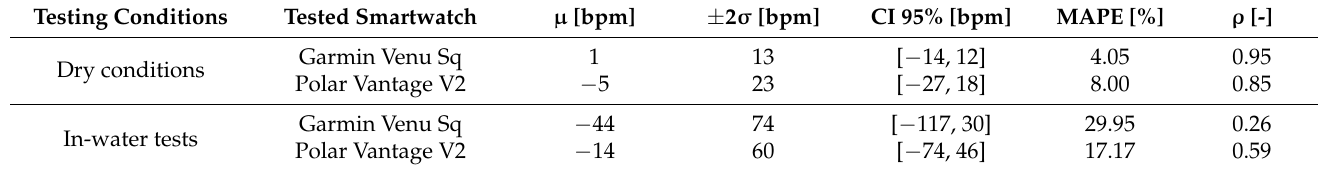
Table 3. Metrological performance of the tested smartwatches in terms of measurement accuracy ( µ ) and precision ( ± 2 σ ), confidence interval at 95% (CI95%), mean absolute percentage error (MAPE), and Pearson’s correlation coefficient ( ρ )—dry vs. in-water